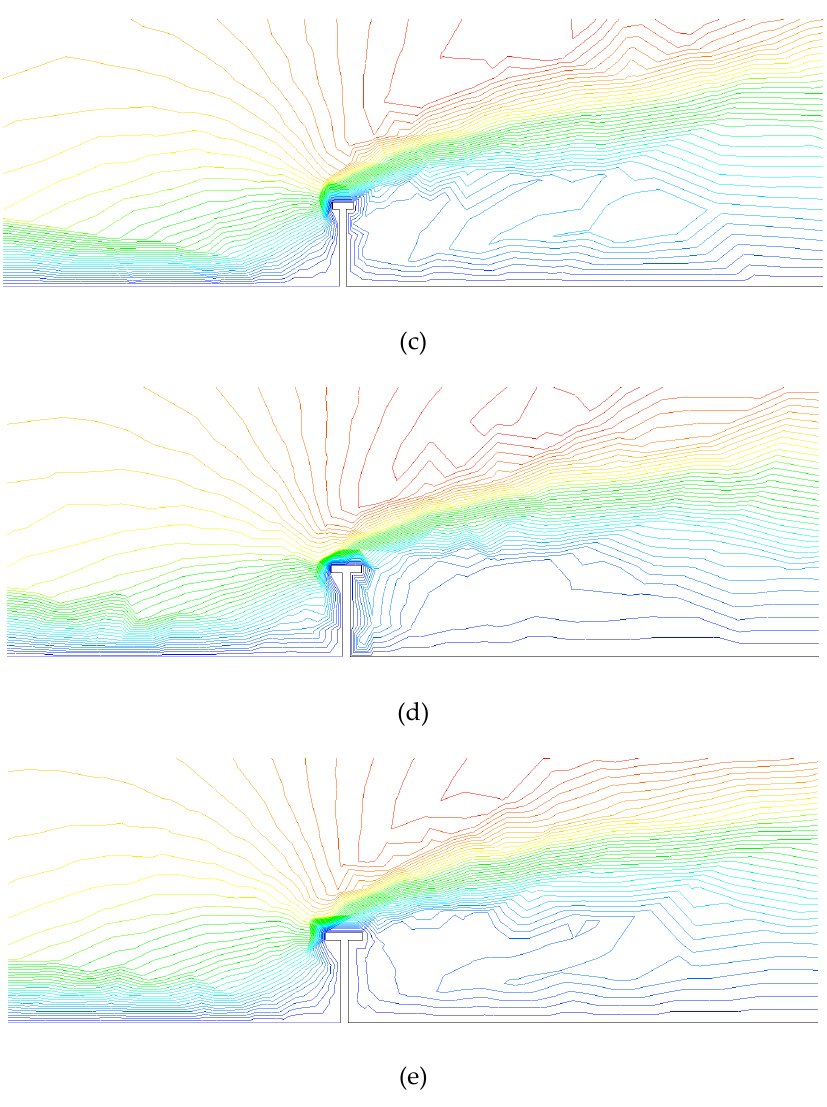
Figure 19. Wind velocity streamline on symmetry. ( a ) Base case; ( b ) case 1; ( c ) case 2; ( d ) case 3; ( e ) case 4.